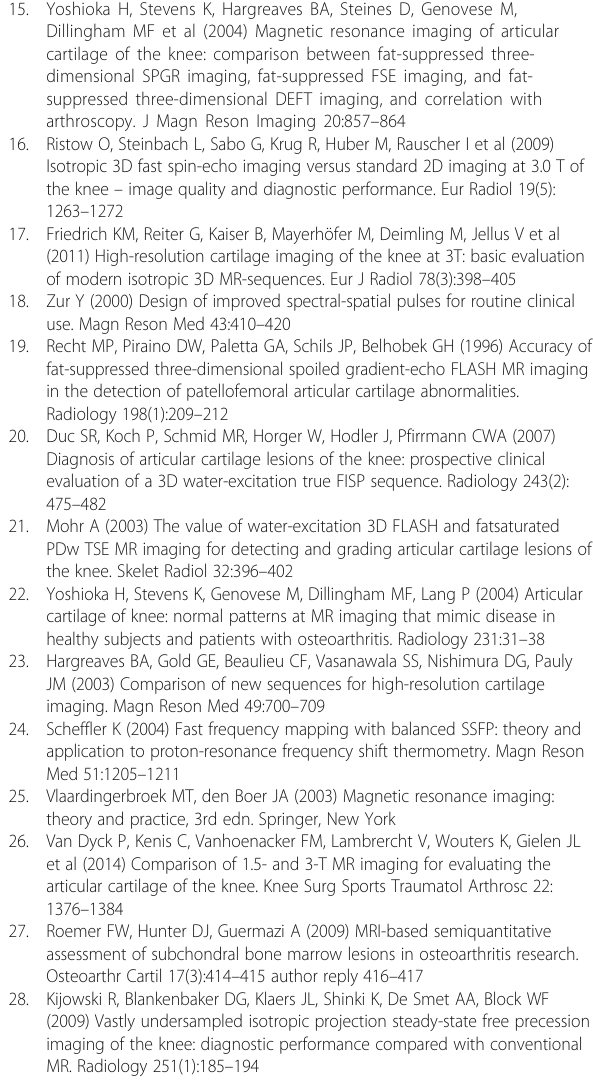
cartilage of the knee: comparison between fat-suppressed three- dimensional SPGR imaging, fat-suppressed FSE imaging, and fat- suppressed three-dimensional DEFT imaging, and correlation with arthroscopy. J Magn Reson Imaging 20:857 –